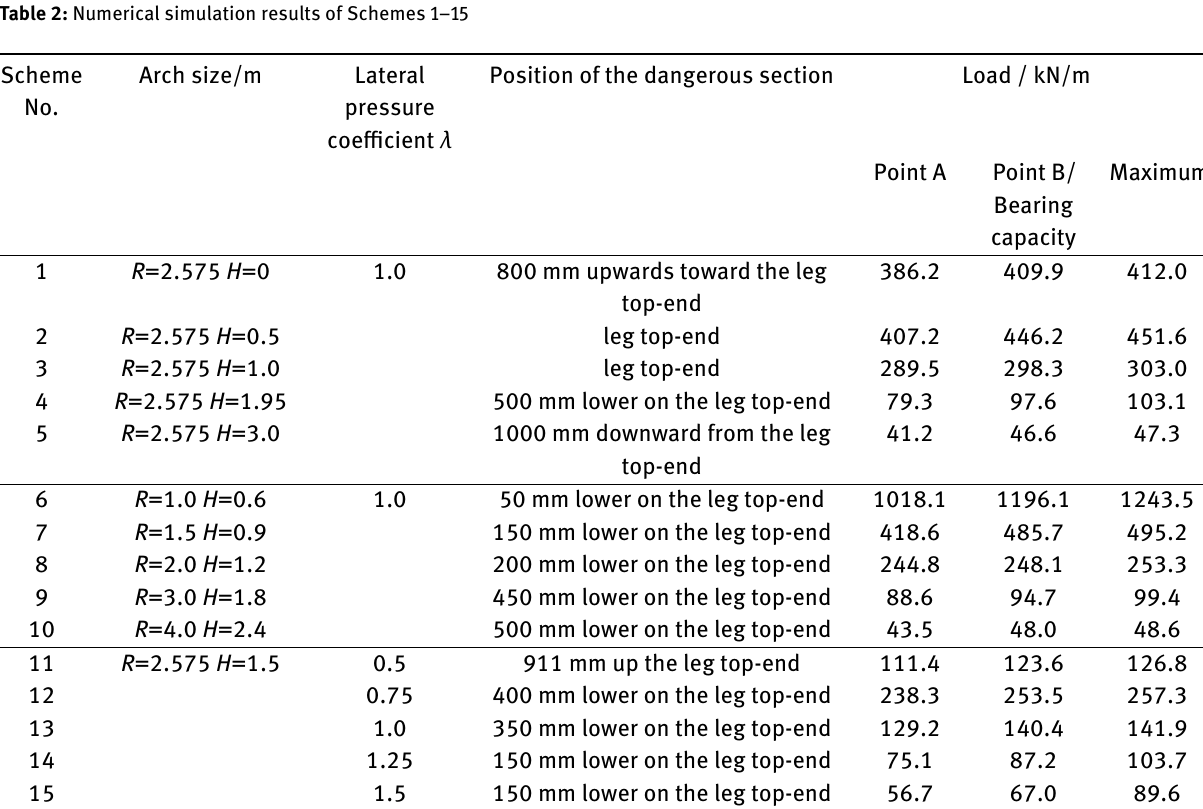
Figure 5: Full size tests of the CFST arches. Table 2: Numerical simulation results of Schemes